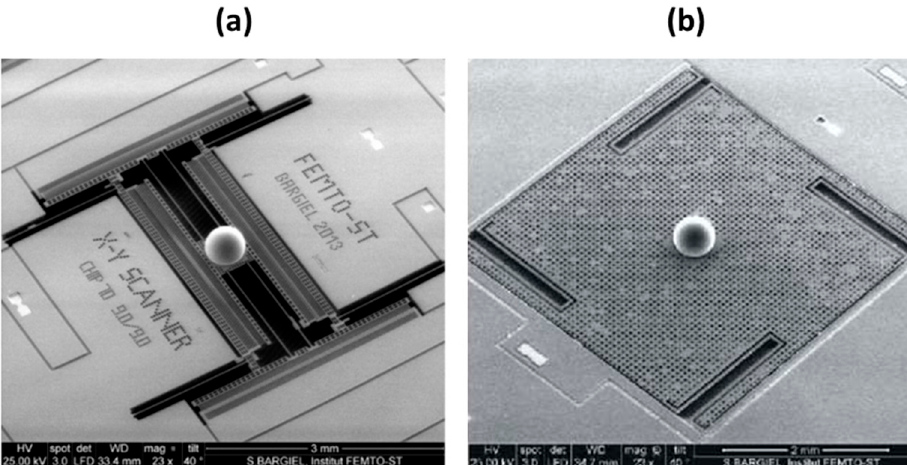
Figure 18. Fabricated microlens scanners after microlens integration: ( a ) SEM of individual chip of x-y microscanner and, ( b ) SEM of individual chip of z microscanner. Reproduced with permission from [13], published by OSA Publishing, 2015.